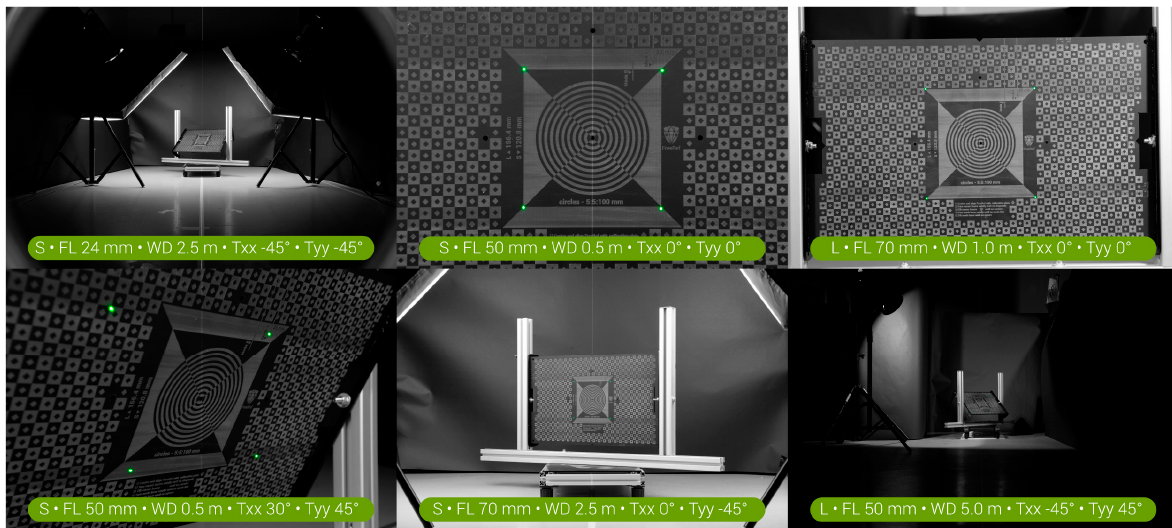
Figure 7. Six arbitrary examples of the photos with the calibration plate used in the verification tests for the tested use conditions. S = S-mode, L = L-mode, FL = focal length, WD = working